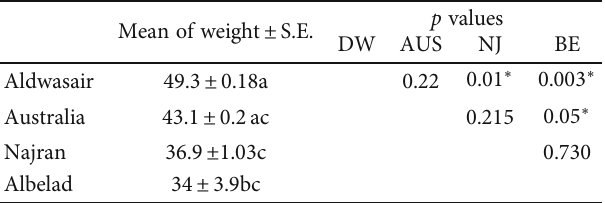
Table 3: Number of F progeny and the length of developmental 1 period of Oryzaephilus surinamensis (L.) reared on four wheat cultivars upon 5 d of egg-laying by 10 female adults.